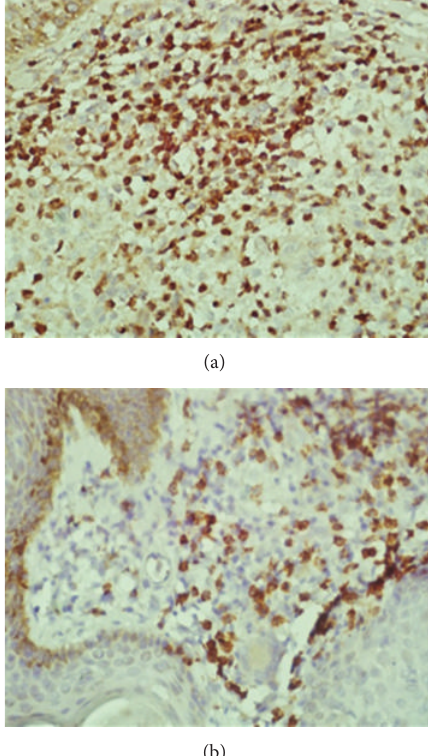
Figure 5: Of patient no. 1. The figures on the left and the right were stained for CD3+ and CD8+ cells. The majority of the cells in (a) are CD3+-positive T cells. (b) shows CD8+-positive cells. The unstained cells are mainly macrophages.